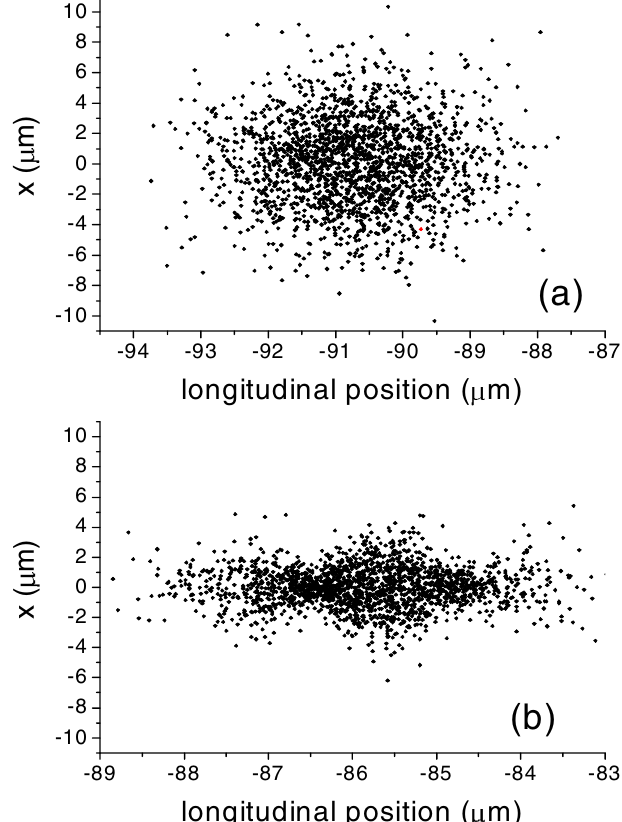
FIG. 5. Injected (a) and accelerated (b) e-bunches in the x - z (cid:1) 400 , the FWHM bunch duration is 7.5 fs, plane. Initially h (cid:4) i 0 (cid:1) 2 : 87 (cid:1) m , " (cid:1) 0 : 95 (cid:1) m , rms energy spread is 2%. (cid:7) x;y nx;y The bunch is injected into the laser wakefield at (cid:6) (cid:1) (cid:2) 9 : 5 (see Figs. 1 and 2). The plasma channel length is 5 cm.